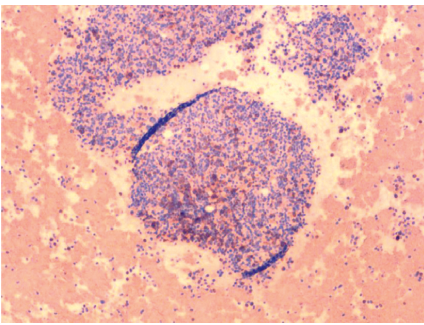
Figure 5: Clot stained with CD25 which is positive in mast